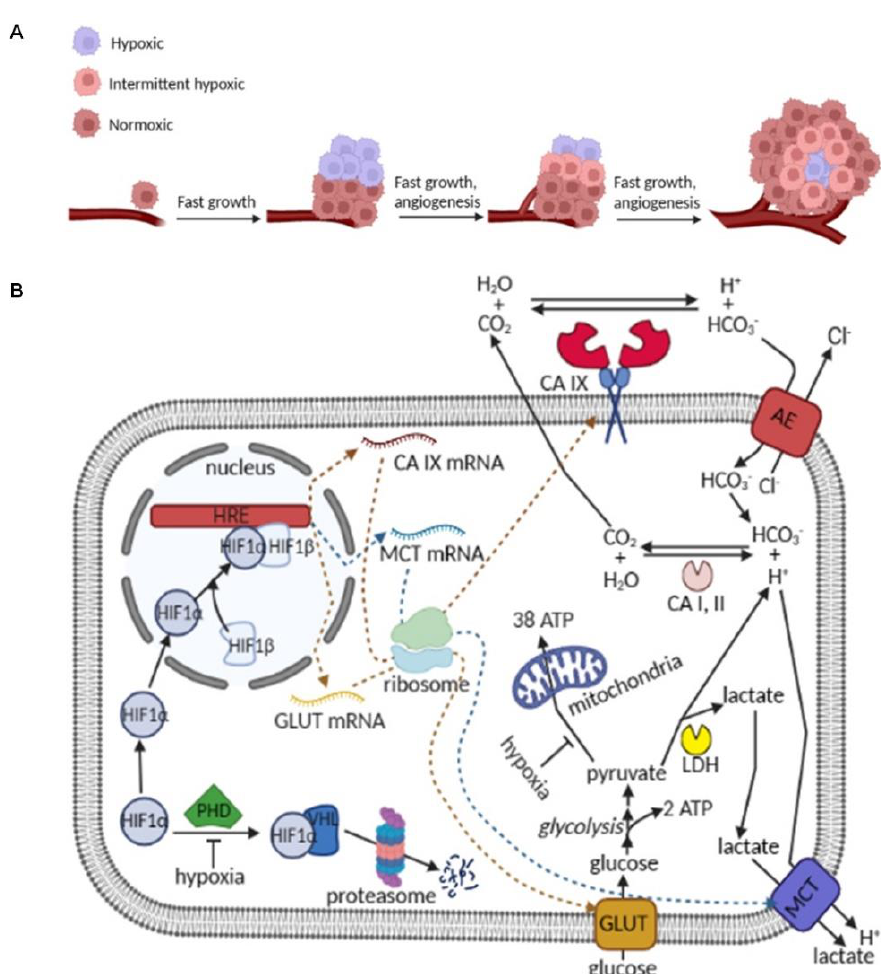
Figure 1. Cartoon depicting the tumor dynamics and microenvironment and highlighting normoxic, intermittent hypoxic and hypoxic area ( A ) and the genotypic and phenotypic changes associated with pH regulation in hypoxic and intermittent hypoxic tumor cells ( B ). Hypoxia stabilizes cytosolic HIF-1 α , which translocates to the nucleus and forms a heterodimer with constitutively stable HIF-1 β . Together, they upregulate the expression of GLUTs, HK, PDK-1, LDH, MCTs and CA IX, among many other genes required for cell adaptation to hypoxia. Glucose transporters (GLUT-1 and GLUT-3); glycolytic enzymes (HK, PDK-1 and LDH) and monocarboxylate transporters (MCT-1 and MCT-4) are significantly upregulated, as cells rely heavily on the anaerobic glycolytic pathway (upregulated 10–15X) for their ATP needs. In tandem with cytosolic carbonic anhydrase isozymes CA I and CA II, CA IX plays a major role in maintaining the intracellular pH homeostasis in tumor cells, acidifying the extracellular milieu.